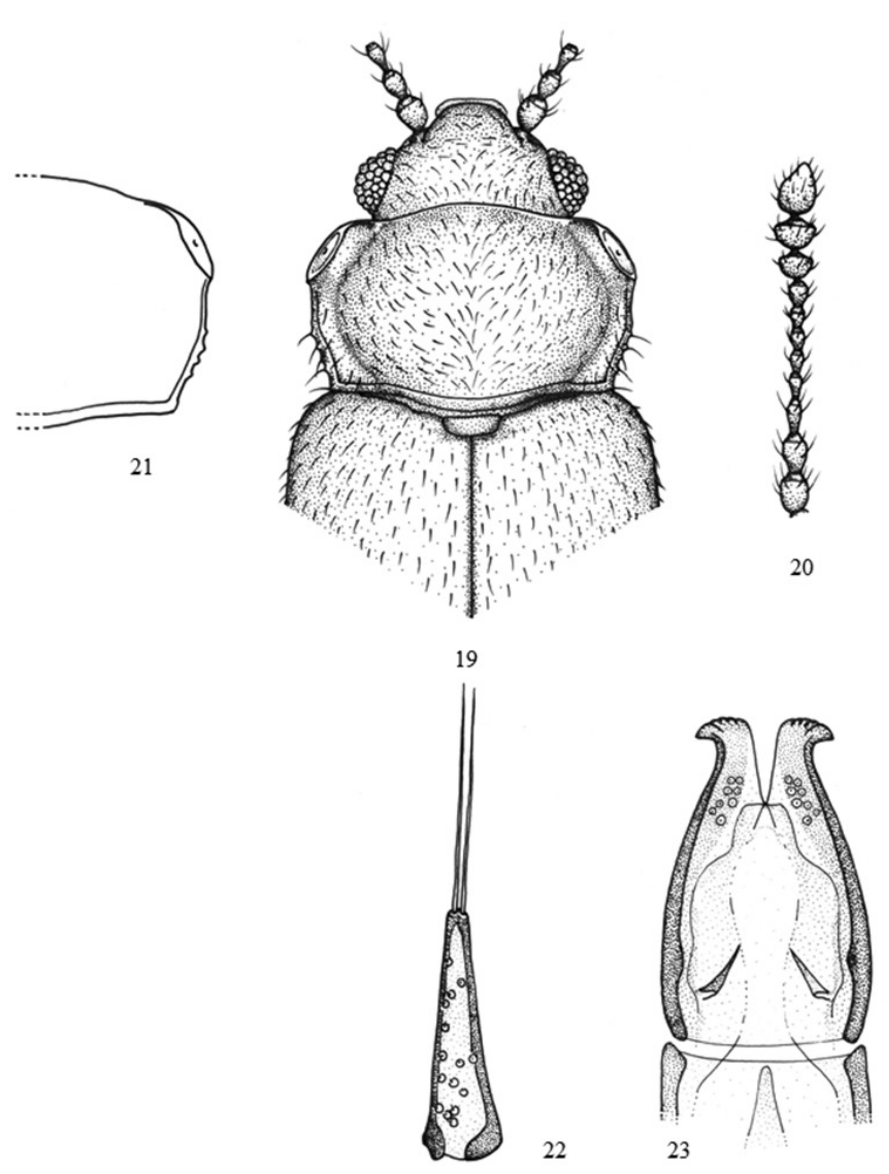
23 aedeagus. up of minute thorns. Parameres (L = 76.75 µm) (Fig. 22) triangular and very elon- gated. Two or three apical setae. Few pores with and without setae. Biology. Some specimens have been captured on Senecio sp. Distribution. Madagascar (Grouvelle 1896); Cameroon (Bruce 1952,